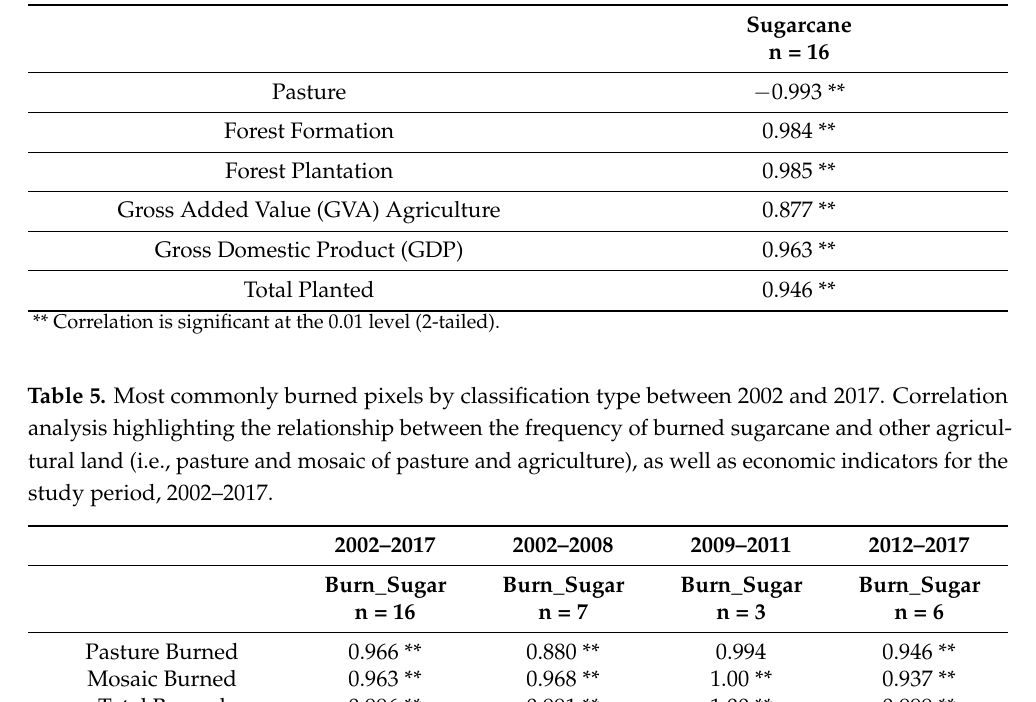
Table 4. Sugarcane correlation results for select variables. Correlation analysis between sugarcane land cover and select land cover types (i.e., pasture, forest), economic indicators for the study period, 2002–2017, and reported acreage of planted sugarcane quantities.